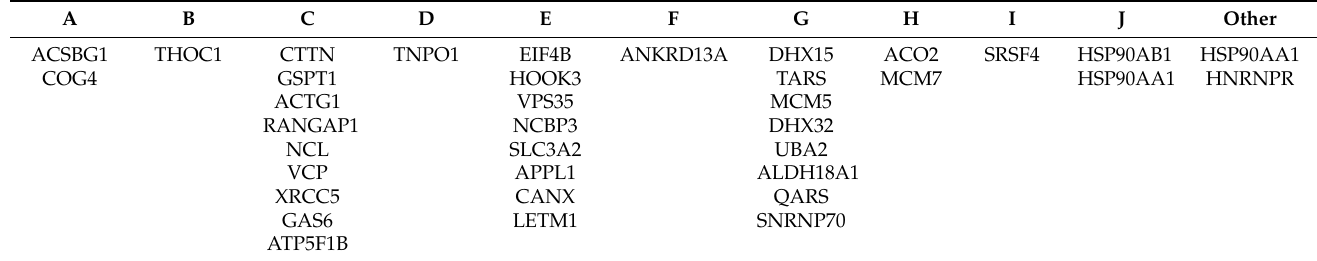
Table 3. Proteins from Sample 1 present in the different categories from Figure